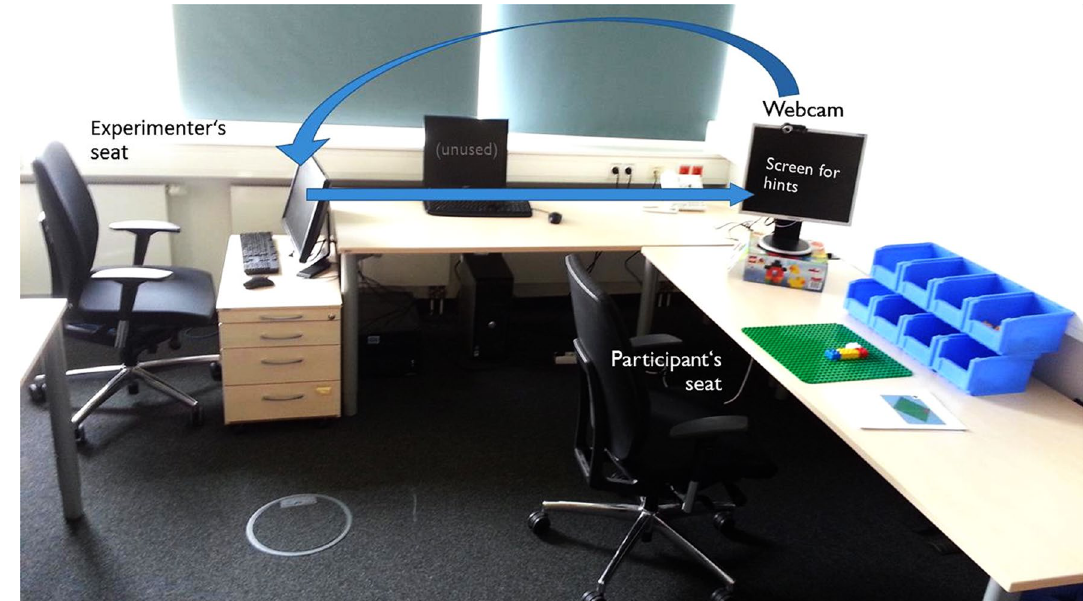
Figure 5. Lab setup for the Duplo assembly study. A webcam live stream of the assembly area enabled the experimenter to observe participants’ actions and intervene on errors by triggering an auditory signal and display the correct action on a screen next to the assembly